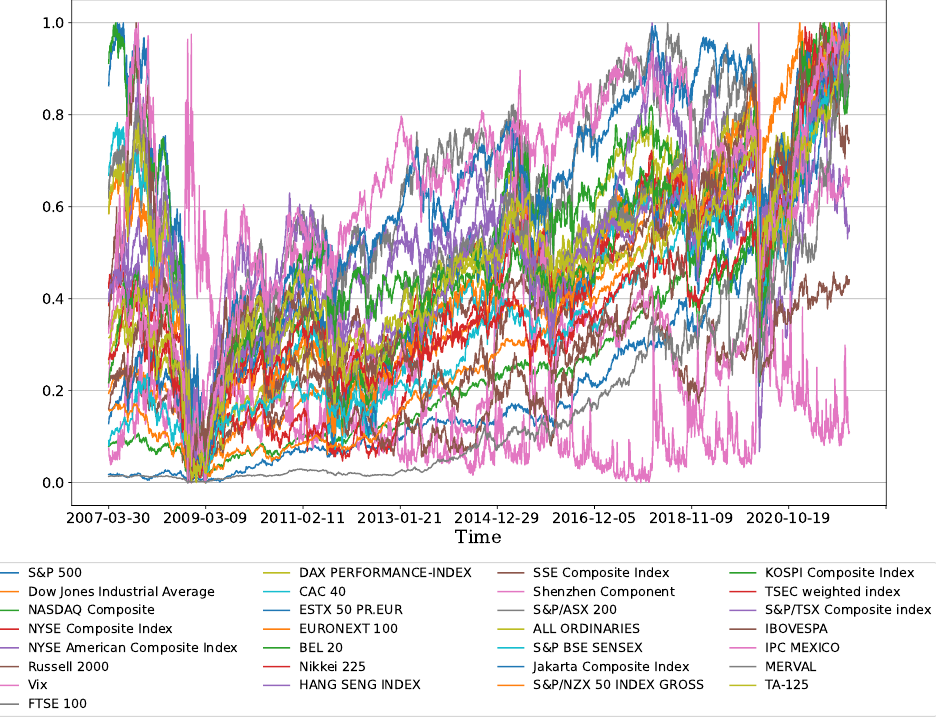
Figure 2. Evolutionary dynamics of the entire samples of international financial market indices between Q1 2007 and Q2 2022 used in the study.